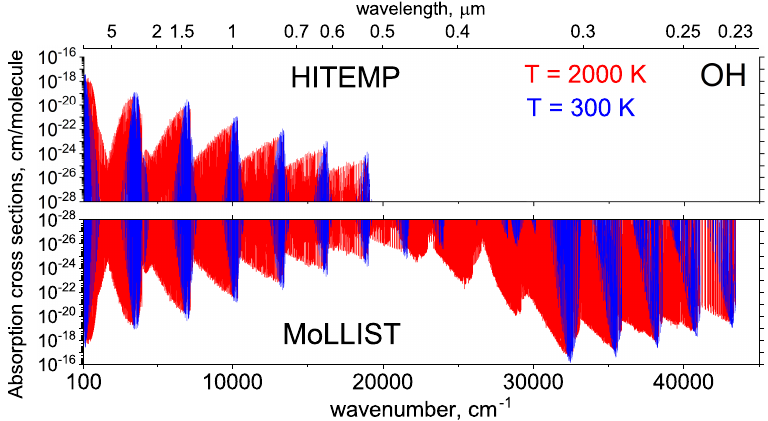
Figure 3. Comparison of the HITEMP [77] and MoLLIST line lists for OH: T = 300 and 2000 K absorption cross sections computed using a Doppler line profile. The MoLLIST spectrum is based on the data from Brooke et al. [33].